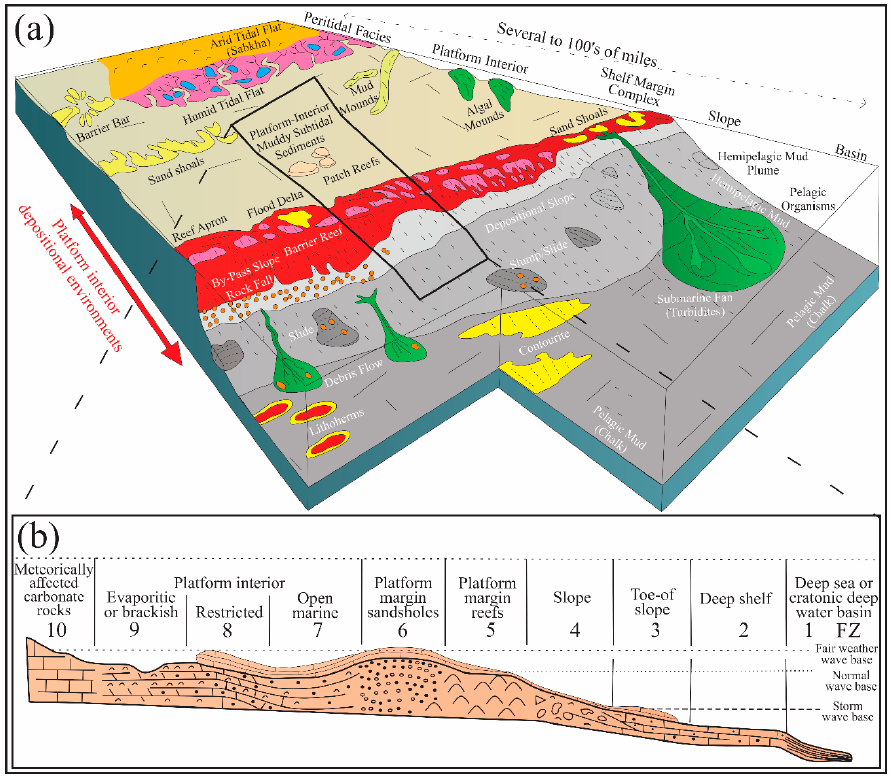
Figure 14. ( a ) Figure illustrating a generalized carbonate platform with associated environments. The rectangle corresponds to ( b ). ( b ) Depositional model of Early–Middle Eocene carbonate rock microfacies on specific zones of the carbonate platform [34].